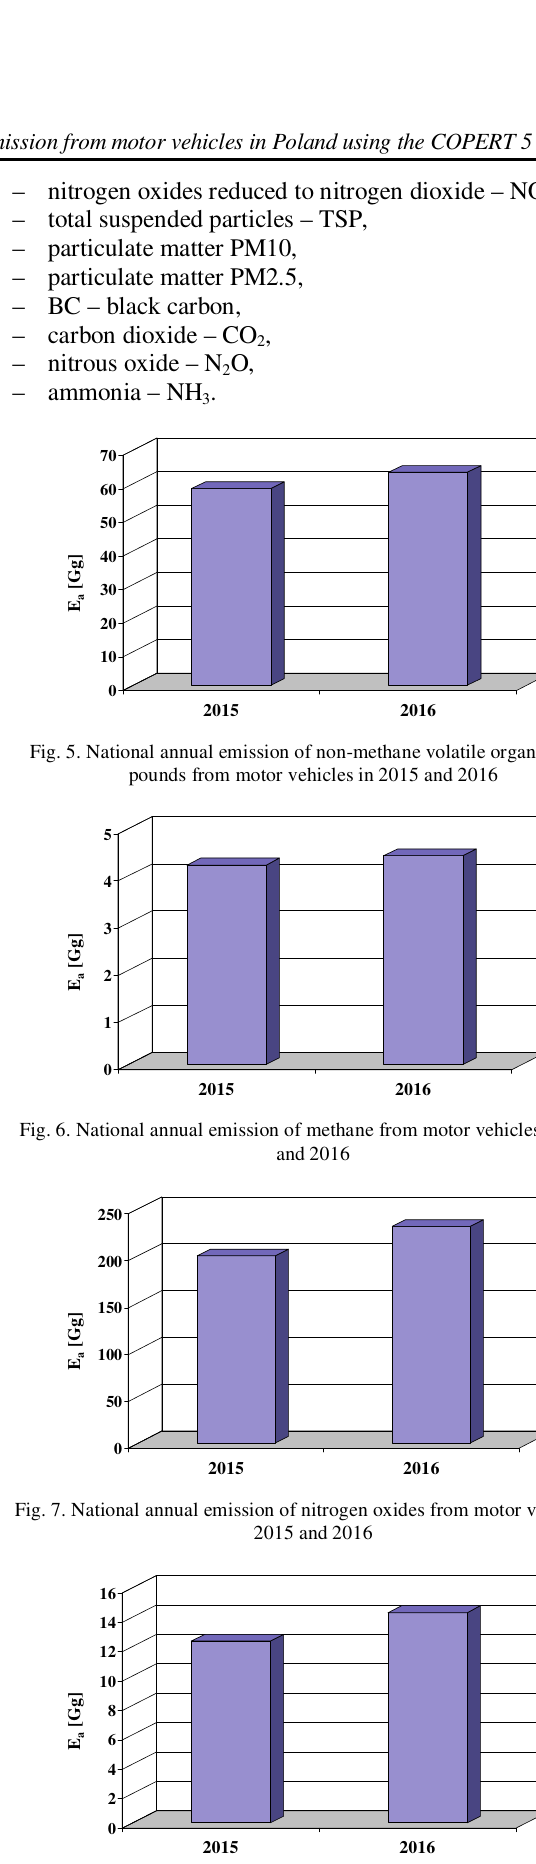
Fig. 8. National annual emission of total suspended particles from motor vehicles in 2015 and